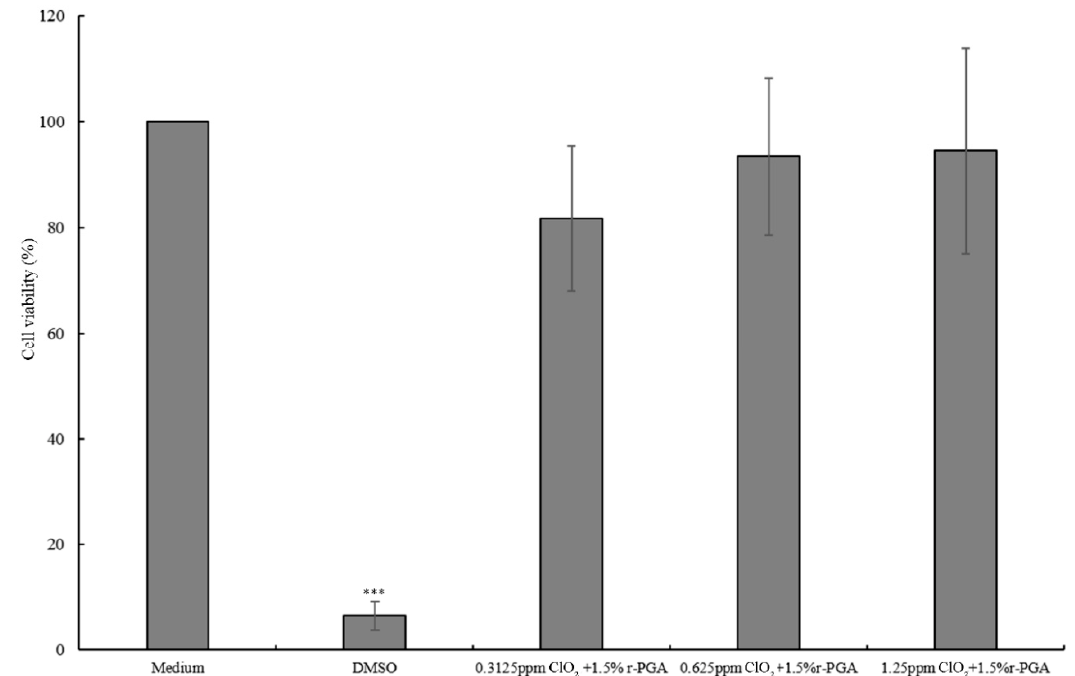
Figure 1. Cytotoxicity testing shows the multipurpose contact lens care solution does not cause cytotoxicity. Cell viability of contact lens care solutions with various concentrations of ClO 2 . *** p < 0.001.